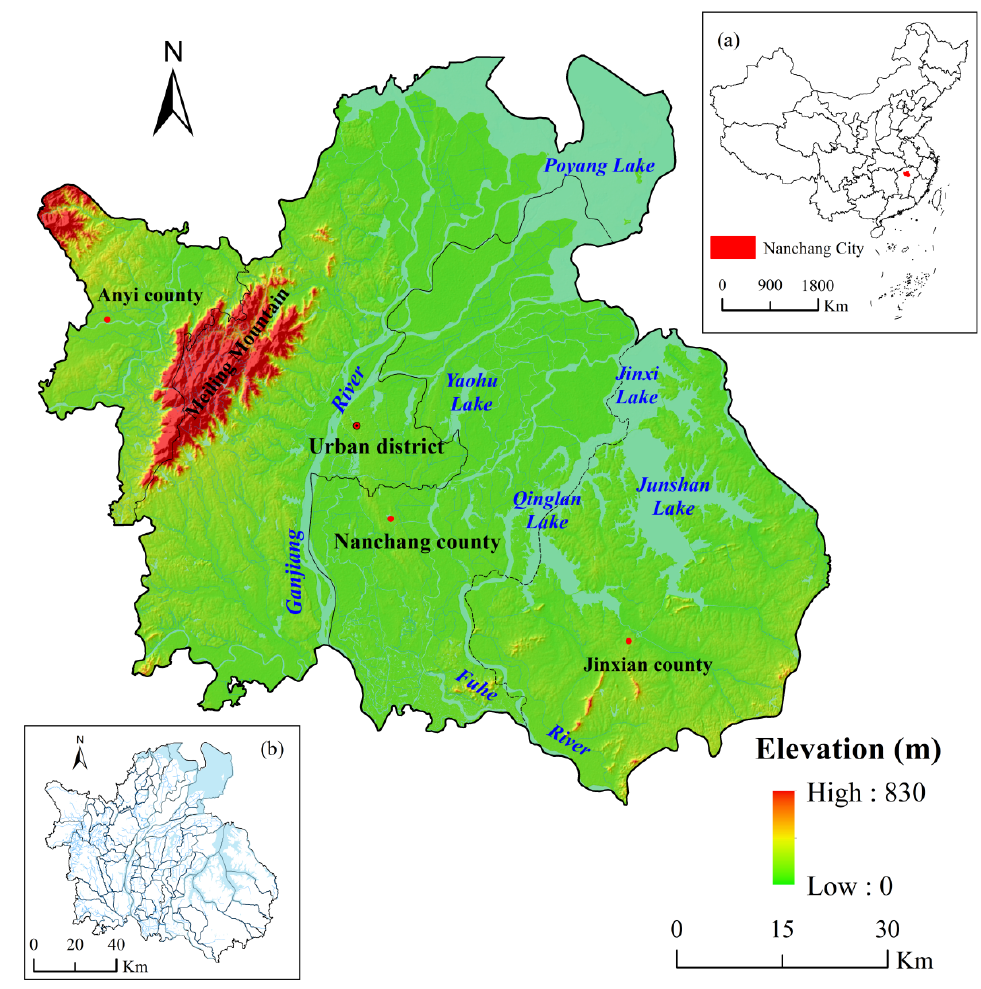
Figure 2. Location ( a ) and site evaluation units ( b ) of the study area.